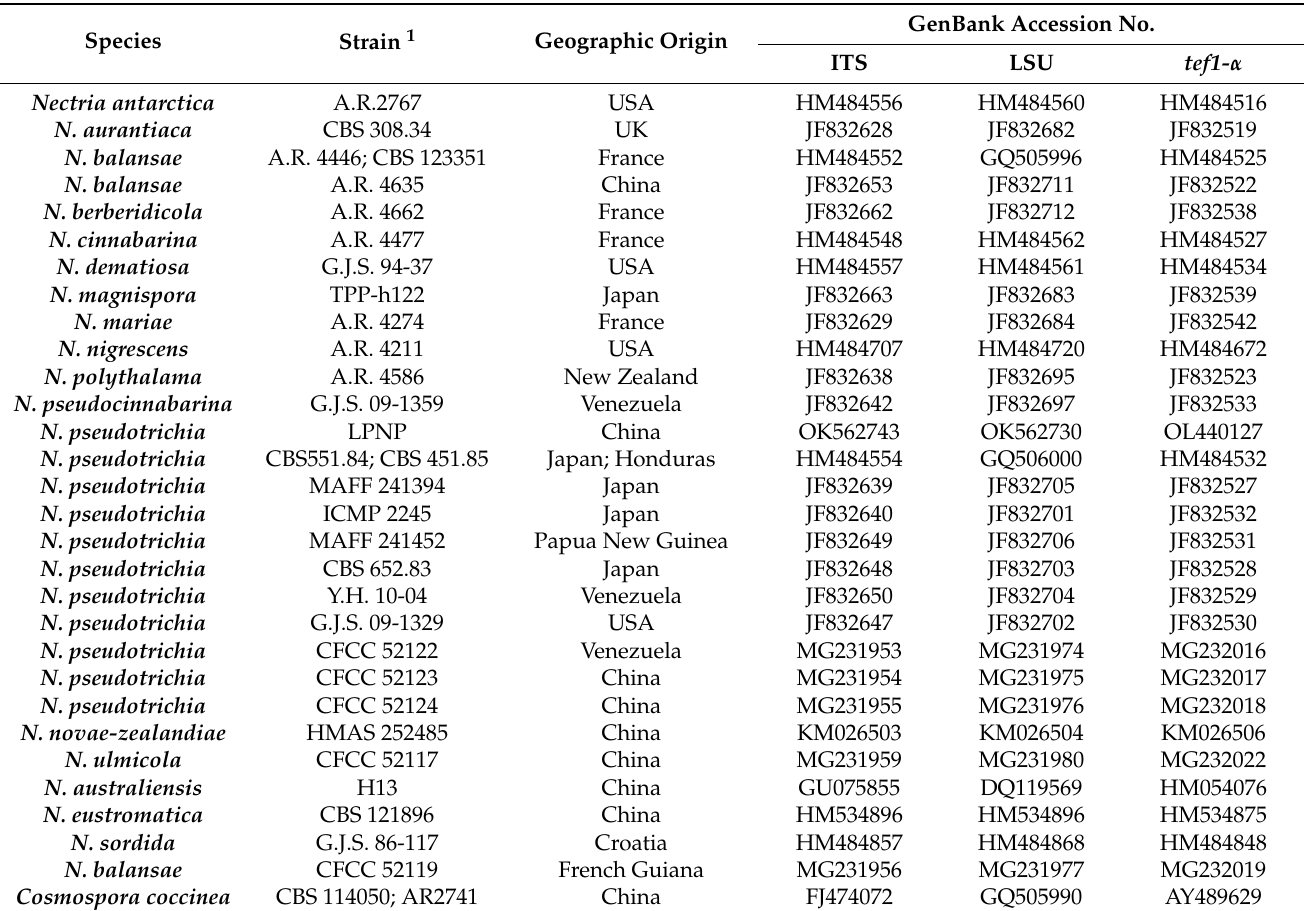
Table 1. Specimens used in phylogenetic analyses and their GenBank accession numbers. Species Strain